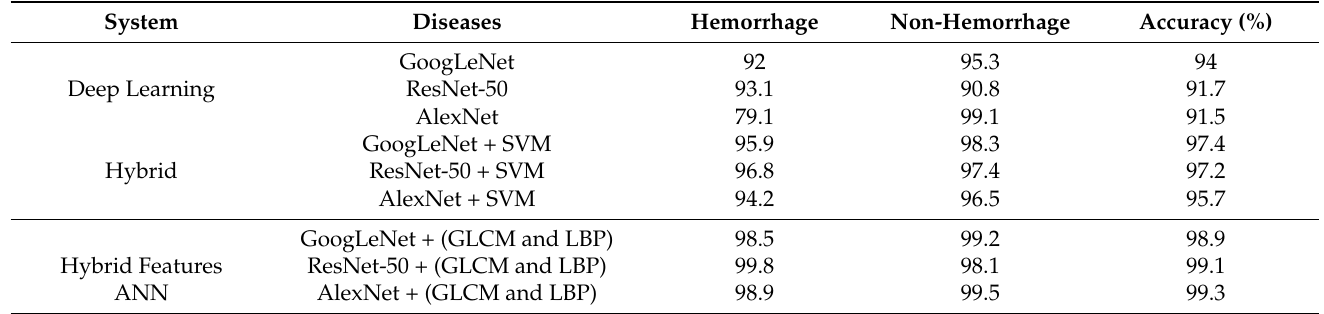
Table 7. Performance of all proposed methods for CT imaging diagnostics for early detection of hemorrhage disease.